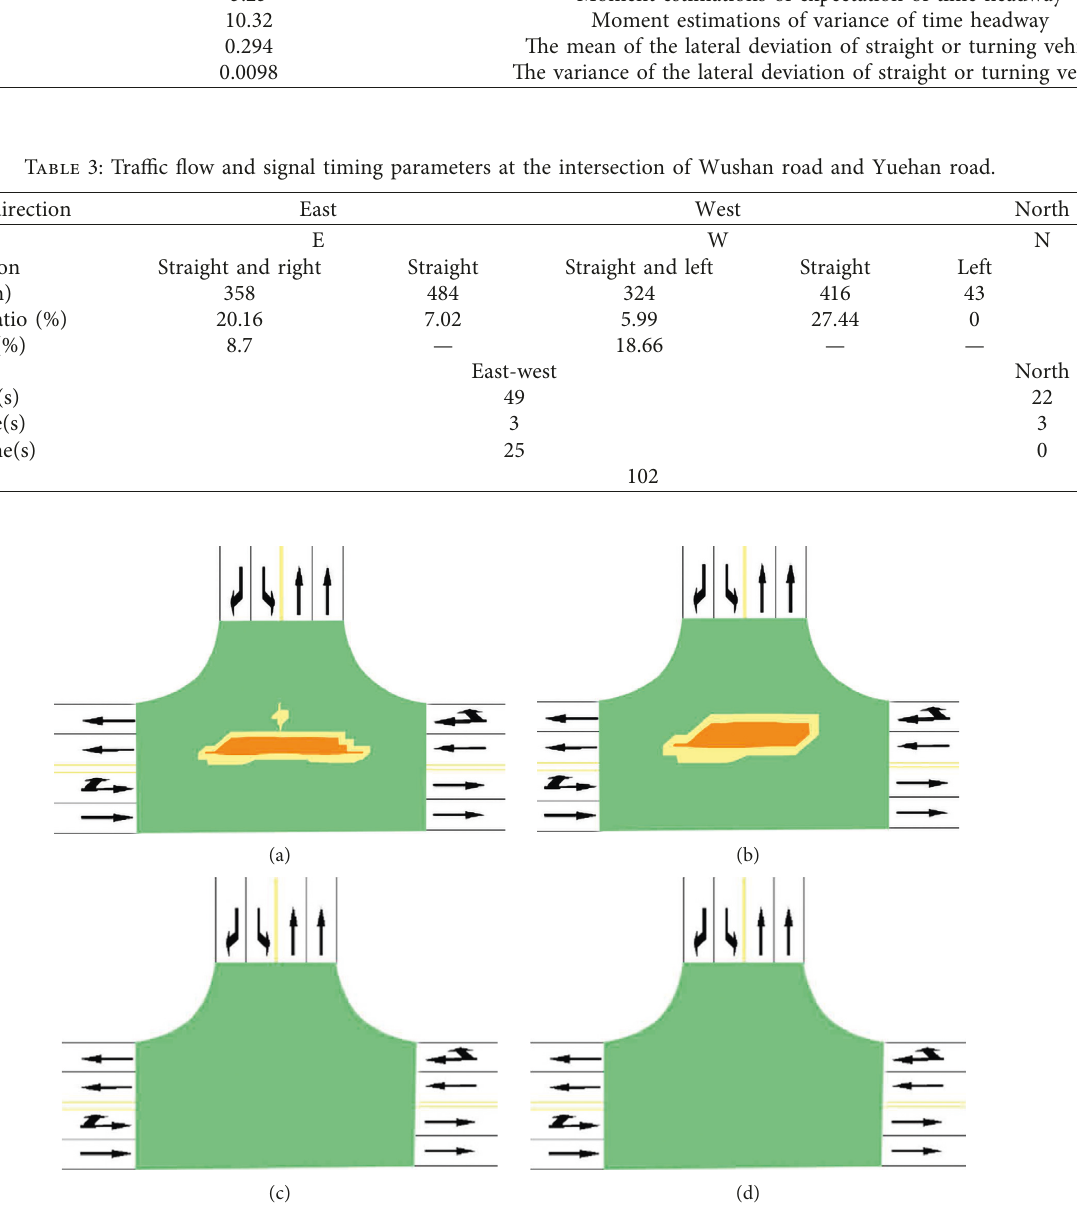
Figure 5: The heat map of the predicted conflict probability in different phases. (a) Phase stage 1. (b) Phase stage 2. (c) Phase stage 3. (d) Phase stage 4.